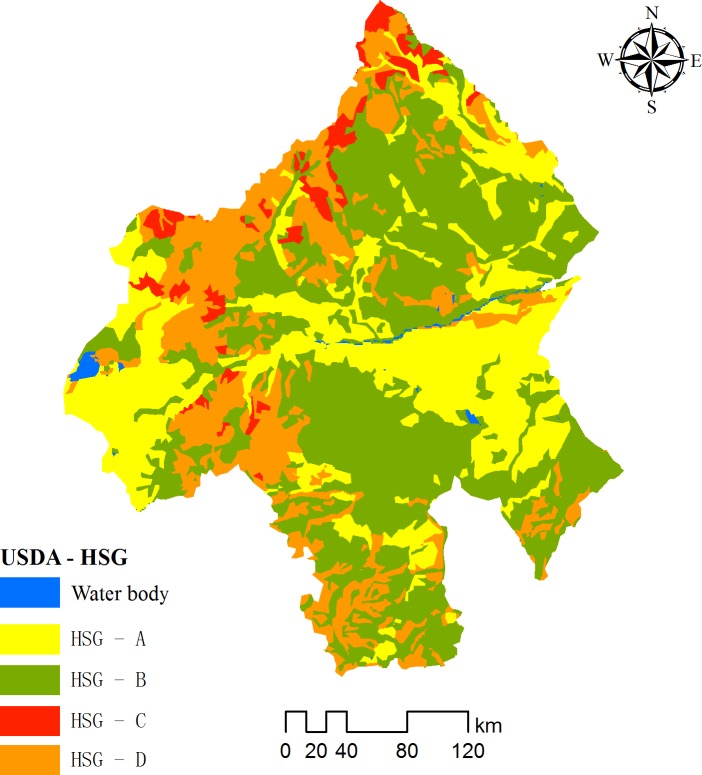
Map of soil types for the study area.